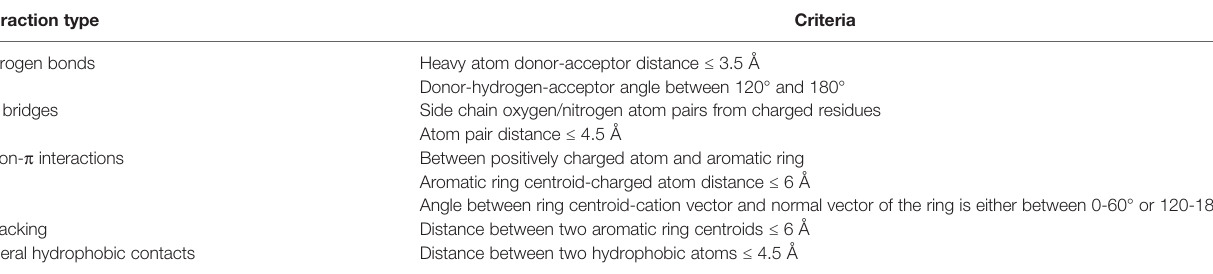
TABLE 2 | Distance and angle criteria for identi fi cation of antibody interface interactions. Interaction